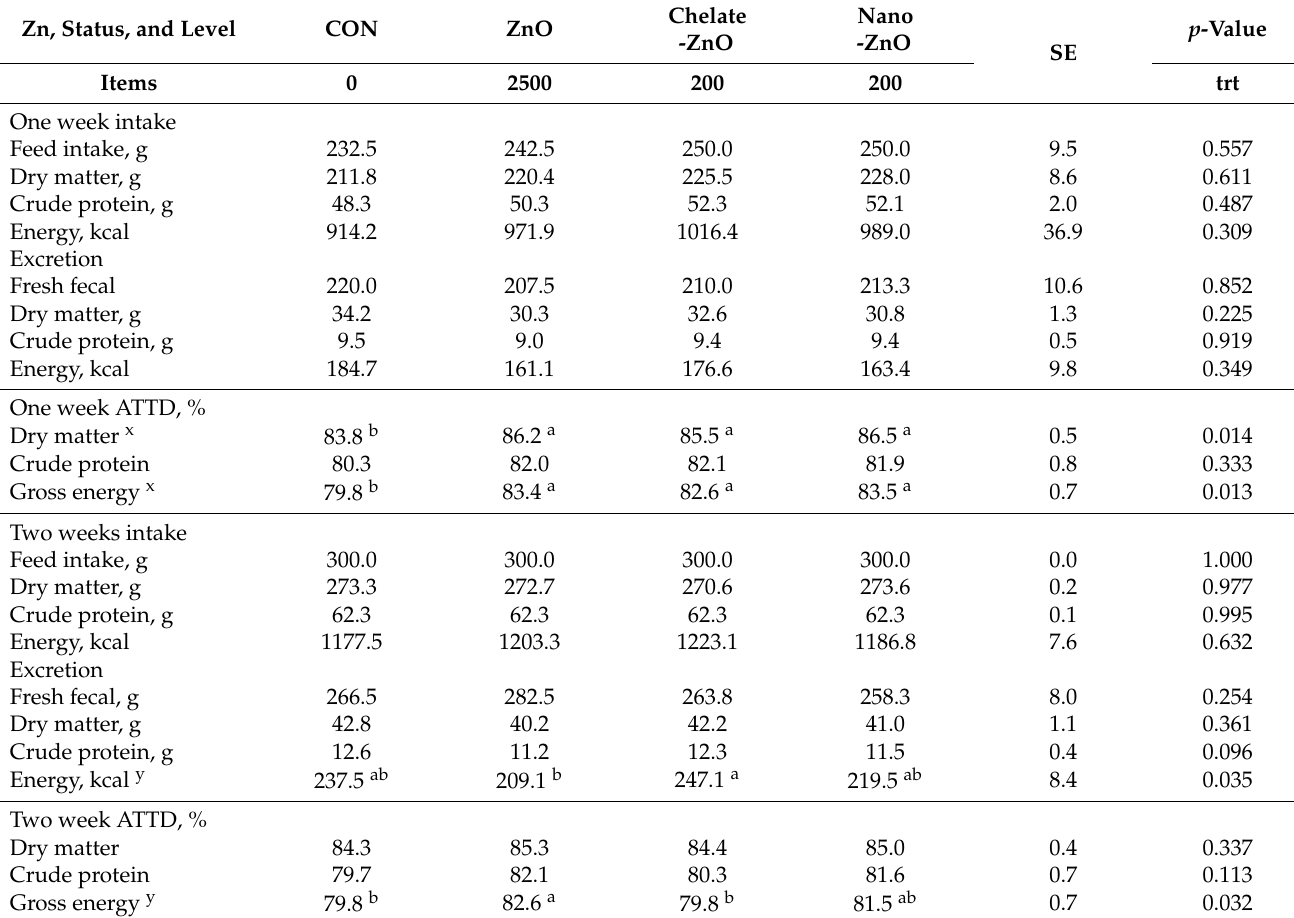
Table 4. Effects of different forms of zinc oxide on the nutrient digestibility of weaned piglets ( n =